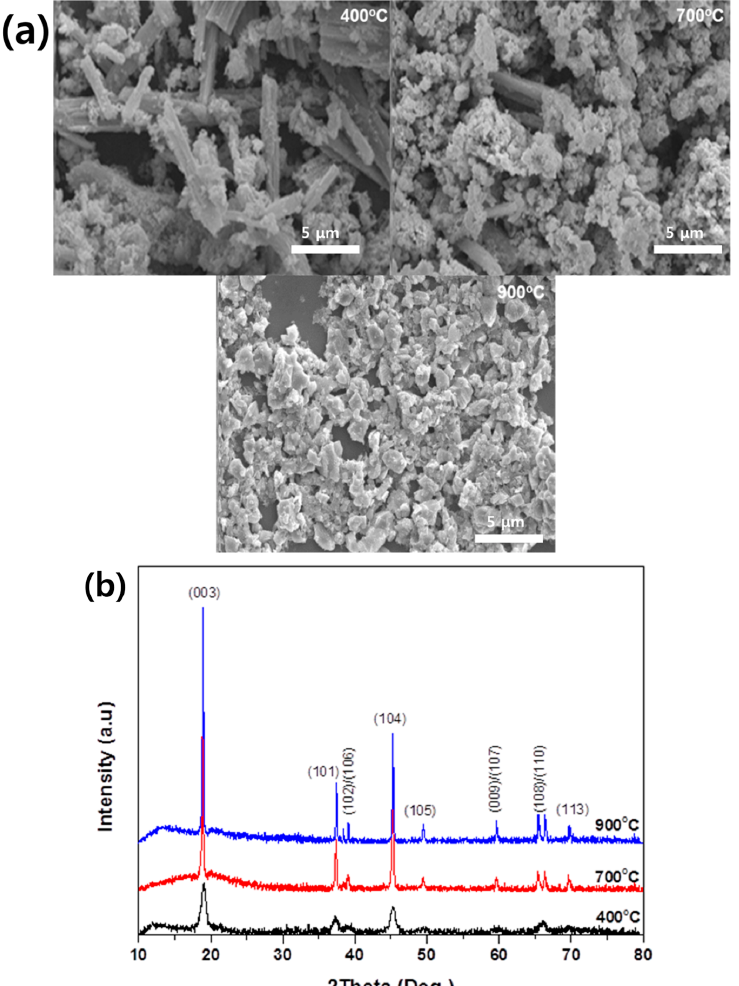
Figure 6. XRD spectrum of LiCoO 2 produced from Co-oxalate by reaction with ( a ) Li 2 CO 3 and ( b ) LiOH.